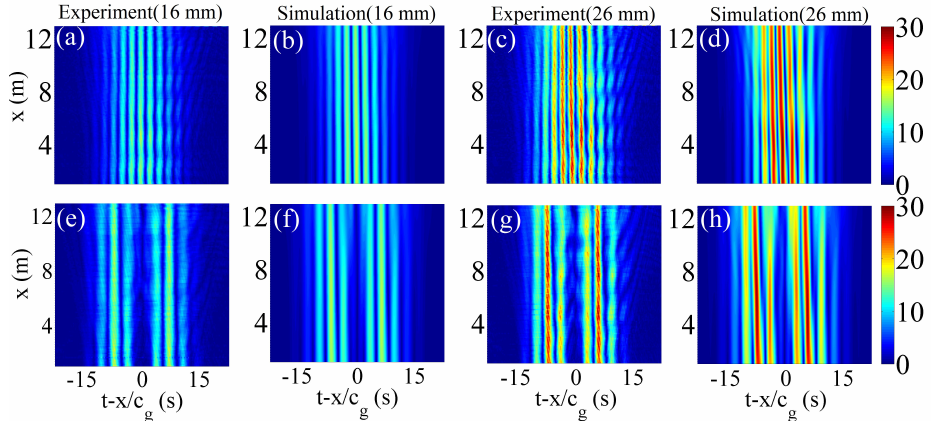
Figure 12. Nonlinear propagation dynamics of HCG0 ( a )–( d ) and HCG1 ( e )–( h ) pulses along the tank for two amplitudes (see the top); ( a )–( d ) t 0 = 9 s, θ = 7.5 ◦ and ( e )–( h ) t 0 = 9 s, θ = 5.5 ◦ . The color bar units are millimeters.